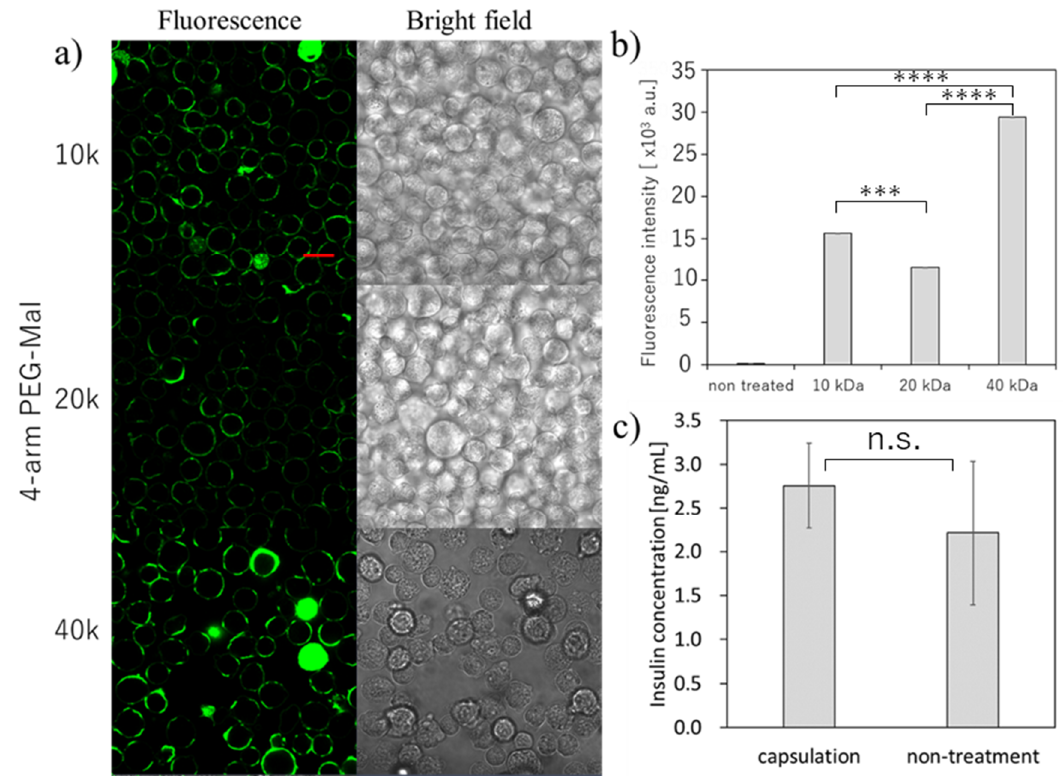
Figure 3. Microencapsulation of beta-TC-6 cells. with different 4-arm PEG-Mal. ( a ) Confocal microscopic images of microencapsulation of beta-TC-6 cells with 4-arm PEG (10k, 20k, and 40k)-Mal. FITC-BSA-SH was used for the visualization of the polymer membrane. Scale bar: 20 µm. ( b ) Quantitative analysis of polymer membranes on beta-TC-6 cells using flow cytometry. Error bars indicate standard deviation; n = 3. ( c ) Glucose-responsive insulin secretion from microencapsulated and non-treated beta-TC-6 cells measured by ELISA. Error bars indicate standard deviation; n = 3. *** = p < 0.001; **** = p < 0.0001; n.s. = not significant.